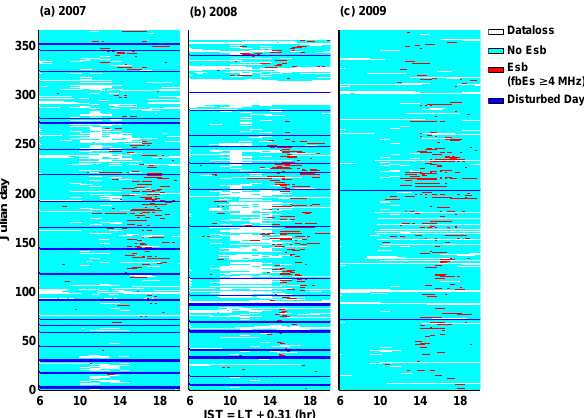
Figure 1. Occurrence of blanketing E s (E sb ) as a function of IST during (a) 2007, (b) 2008 and (c) 2009. Disturbed days ( P Kp ≥ 24) and data loss are shown by blue and white colour